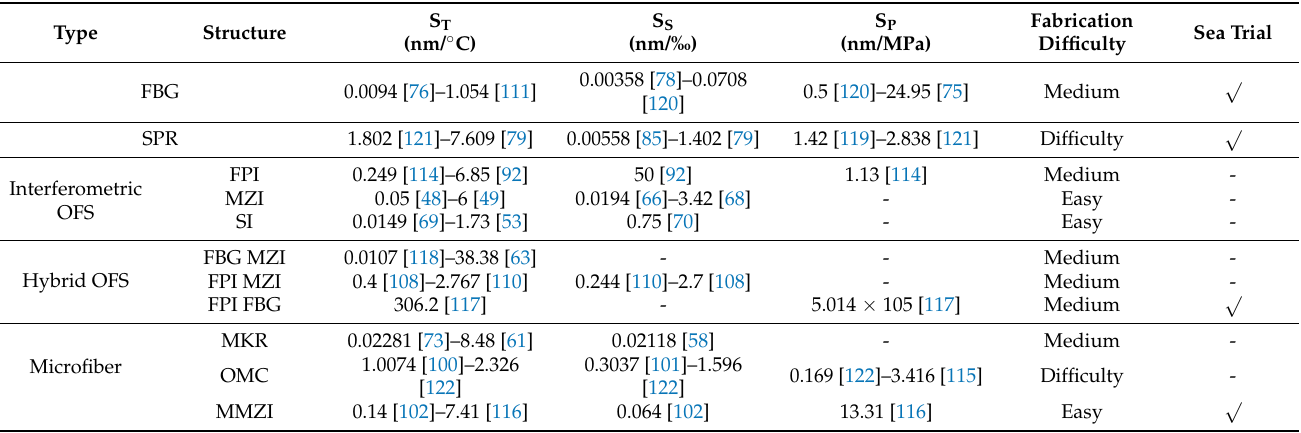
Table 1. Comparisons of different OFSs for TSP sensing and